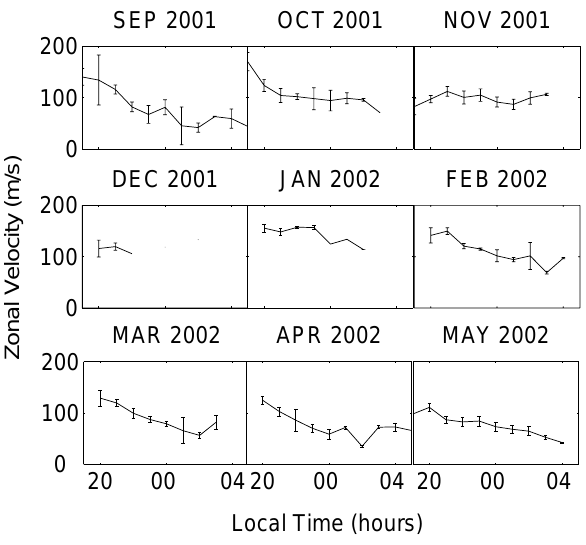
Fig. 9. Monthly mean of hourly GPS scintillation drift velocity. Error bars indicate standard deviations, including measurement and geophysical